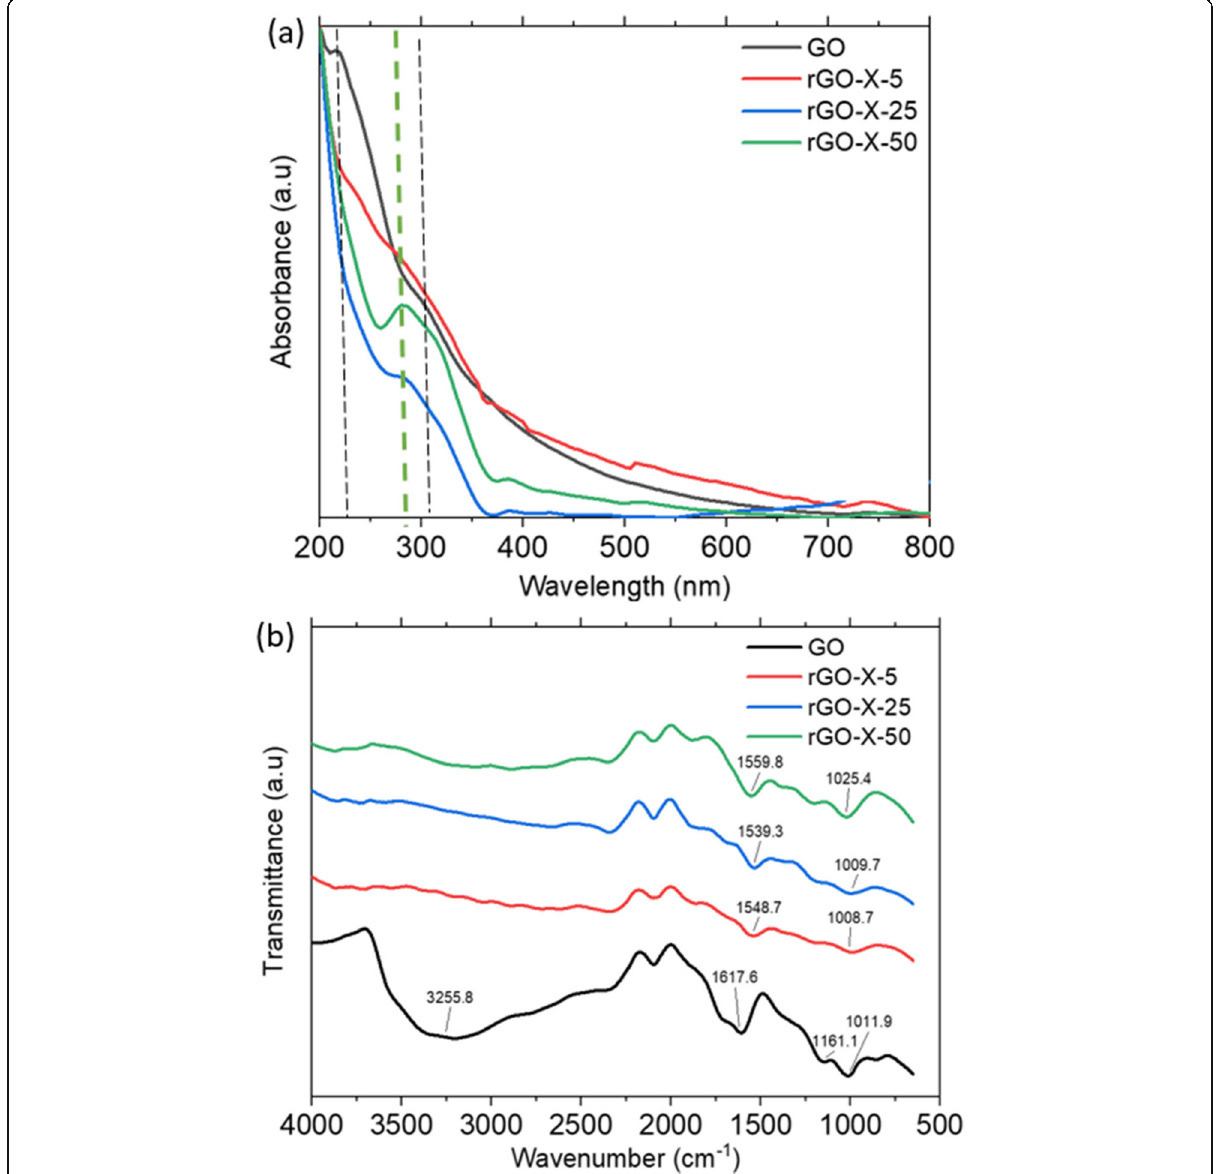
Fig. 2 ( a ) UV – Vis spectroscopy and ( b ) FT-IR spectra of graphene oxide (GO), and reduced graphene oxide (rGO) using different concentrations of Tecoma stans leaves extract (5, 25, and 50 mg mL − 1 of leaves